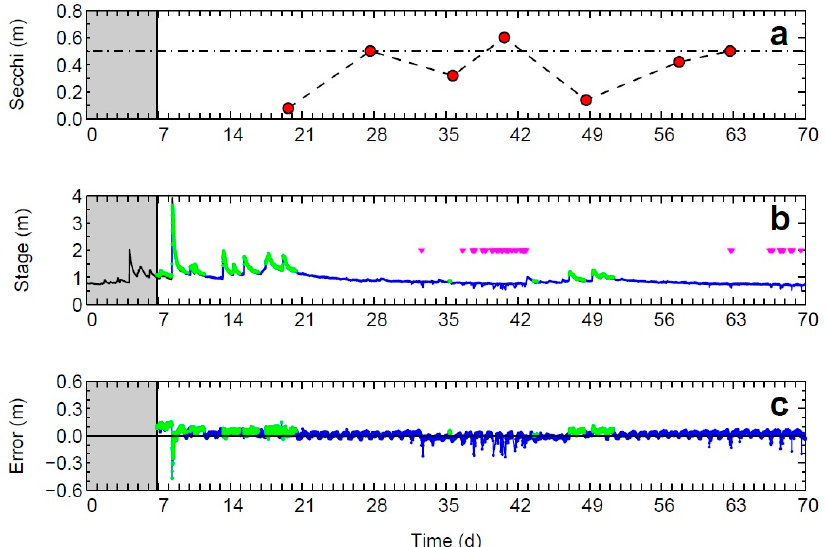
Figure 4. Summary of the monitoring campaign in the Amacuzac River (Mexico): ( a ) water transparency; ( b ) stage data obtained with the reference (black line) and the proposed Lidar technique (blue line shows data associated with moderate signal strength and green line shows data associated with a high signal strength; the triangles represent periods during which the Lidar was unable to provide stage data for more than 15 min); ( c ) error of the proposed technique (i.e., stage estimates minus reference values). Day “0” corresponds to 12 September 2015. Grey areas correspond to the times before the Lidar installation.